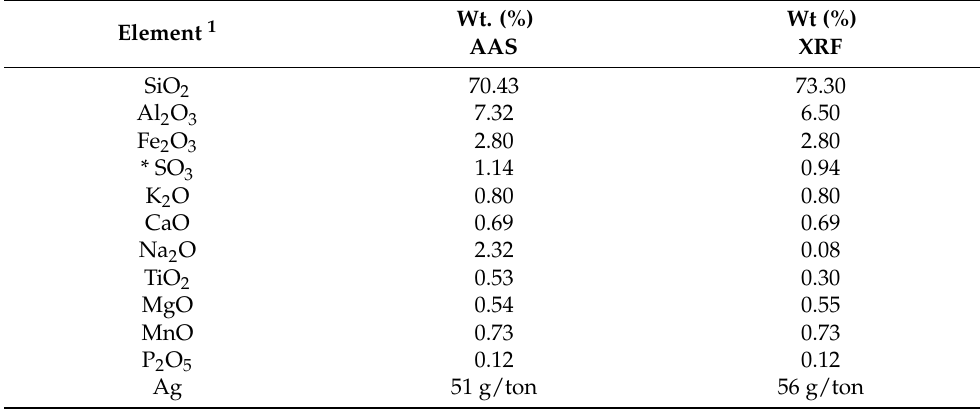
Table 4. Chemical composition of the MW used for leaching of